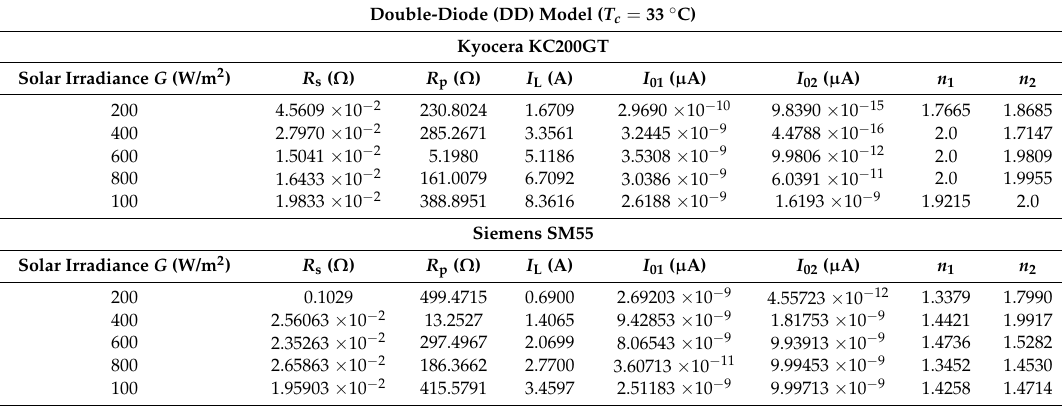
Table 6. DD model PV cell parameters at different solar irradiance levels (200, 400, 600, 800 and 1000 W/m 2 ) and fixed cell temperature ( T c = 33 ◦ C ), extracted by considering an individual PV cell from both the Kyocera KC200GT and Siemens SM55 Solar